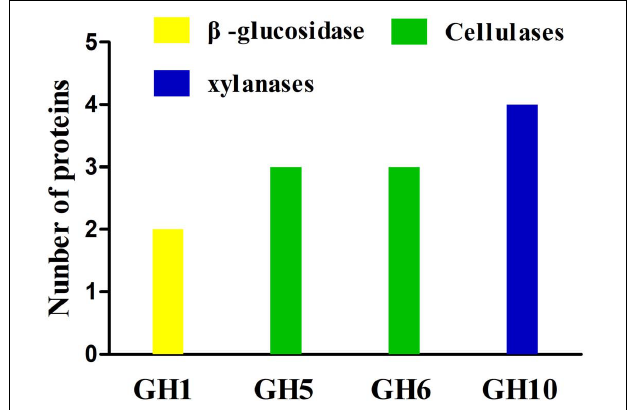
FIGURE 3 | Glycoside hydrolases in the secretome of A. amylolytica .